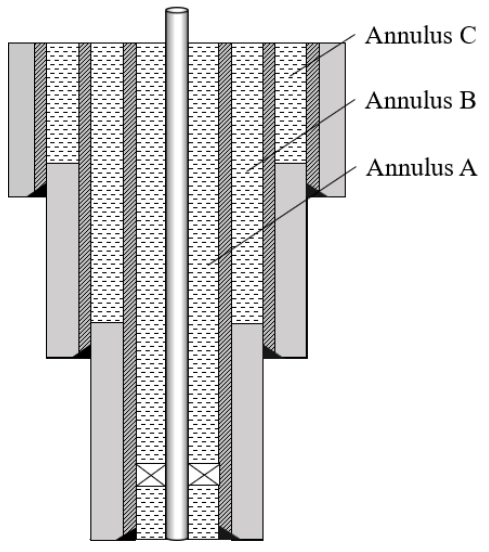
Figure 1. Typical wellbore structure of subsea